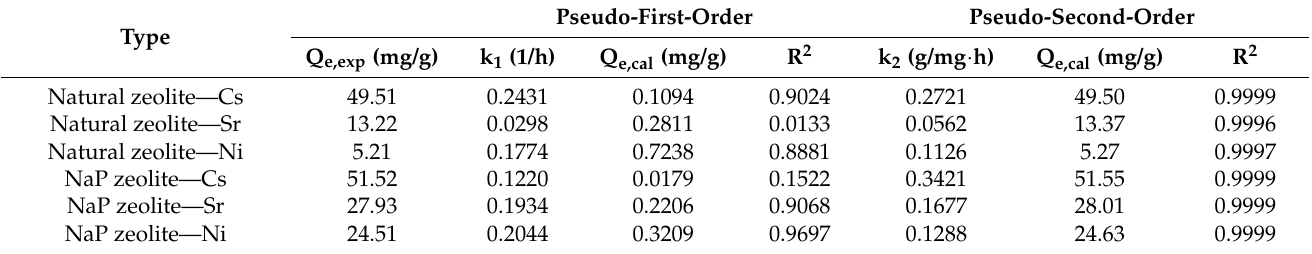
Table 1. Results of the pseudo-first-order and pseudo-second-order adsorption kinetics models.